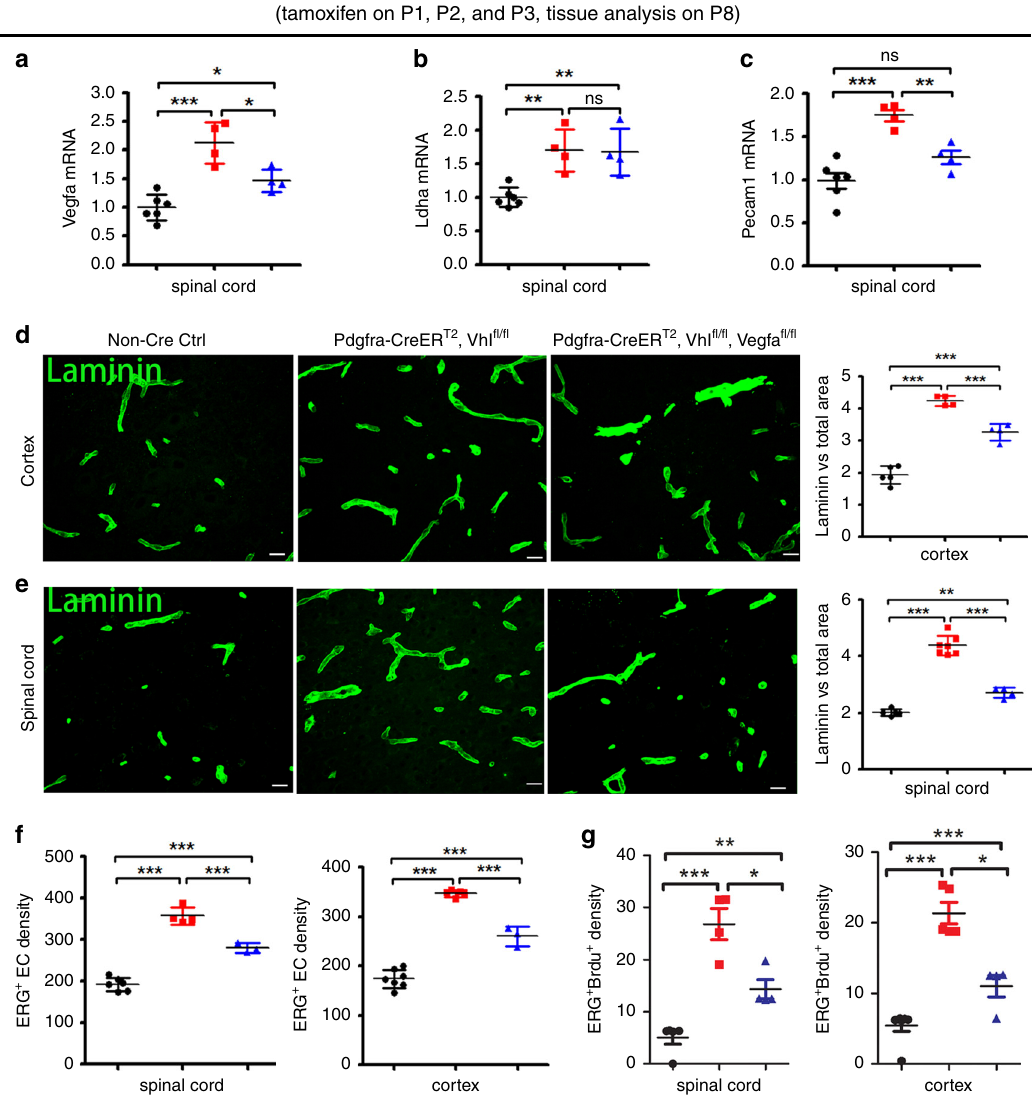
Fig. 7 Oligodendroglial HIF α regulates CNS angiogenesis through VEGFA-mediated signaling. a – c RT-qPCR assay of the mRNA levels of Vegfa, Ldha, and Pecam1 in the spinal cord of each group of mice. One-way ANOVA followed by Tukey ’ s multiple comparisons, * P < 0.05, ** P < 0.01, *** P < 0.001, ns not signi fi cant. F (2,11) = 21.74, P = 0.0002 Vegfa; F (2,11) = 11.50, P = 0.0020 Ldha ; F (2,11) = 20.31, P = 0.0002 Pecam1 . n = 6 Ctrl, 4 VHL cKO, 4 VHL/VEGFA cKO. d , e Representative confocal images and quanti fi cation of Laminin-positive blood vessels. One-way ANOVA followed by Tukey ’ s multiple comparisons, ** P < 0.01, *** P < 0.001, ns not signi fi cant. F (2,10) = 105.5, P < 0.0001 cortex, n = 5 Ctrl, 4 VHL cKO, 4 VHL/VEGFA cKO.; F (2,13) = 133.2, P < 0.0001 spinal cord, n = 5 Ctrl, 7 VHL cKO, 4 VHL/VEGFA cKO. Scale bars = 10 μ m. f , g densities (#/mm 2 ) of ERG + ECs and ERG + BrdU + proliferating ECs. One-way ANOVA followed by Tukey ’ s multiple comparisons, * P < 0.05, ** P < 0.01, *** P < 0.001. ERG + ECs, F (2,10) = 113.1, P < 0.0001 spinal cord, n